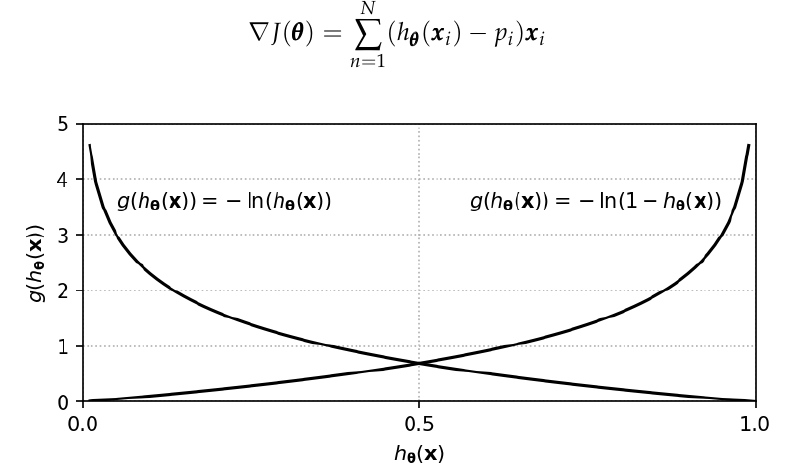
Figure 1. The functions g ( h θθθ ( xxx )) = − ln ( h θθθ ( xxx )) and g ( h θθθ ( xxx )) = − ln ( 1 − h θθθ ( xxx )) that contribute to the elements of the summation in Equation